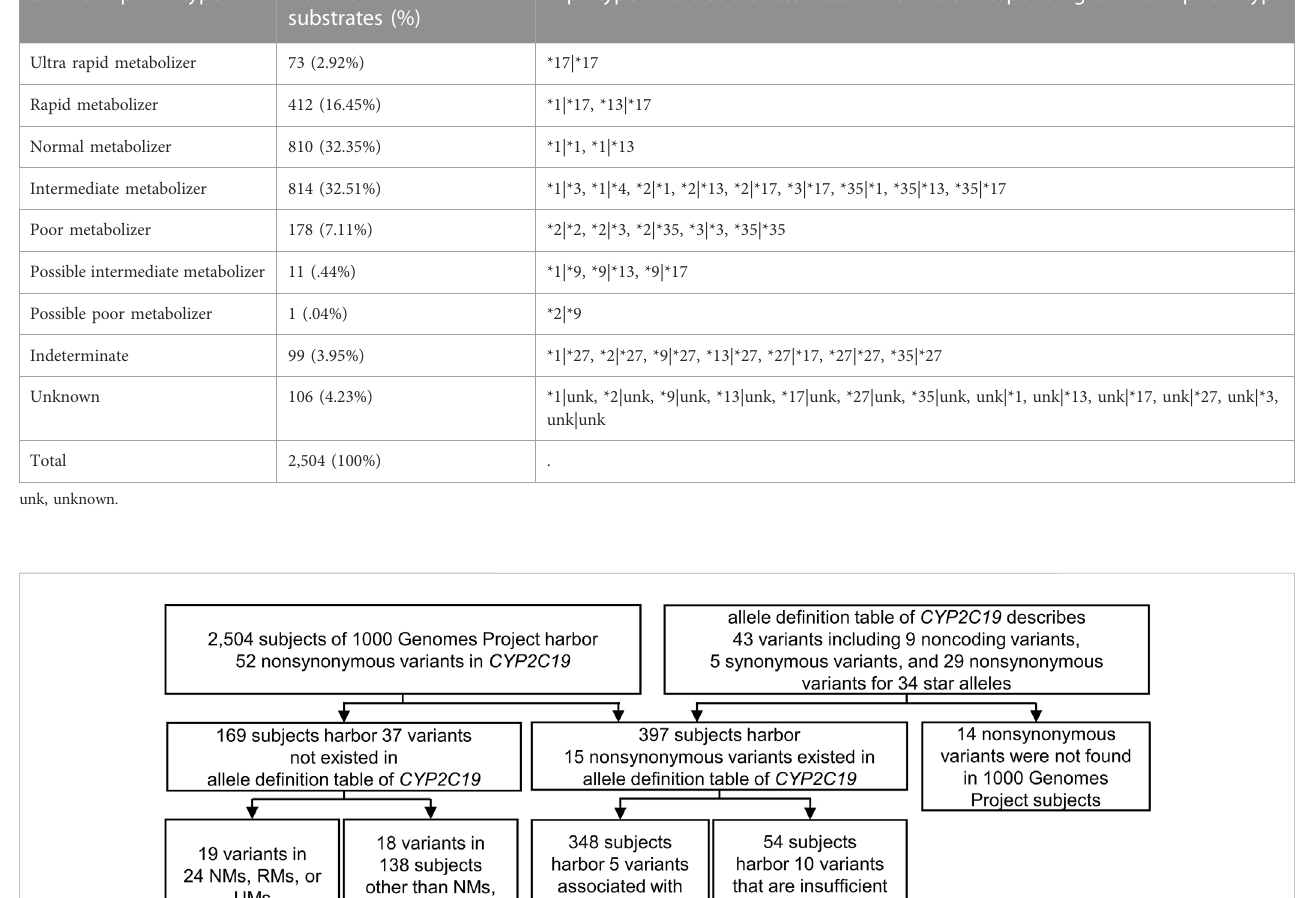
TABLE 1 CYP2C19 phenotype and diplotype of 2,504 substrates in the 1000 Genomes Project. CYP2C19 phenotype